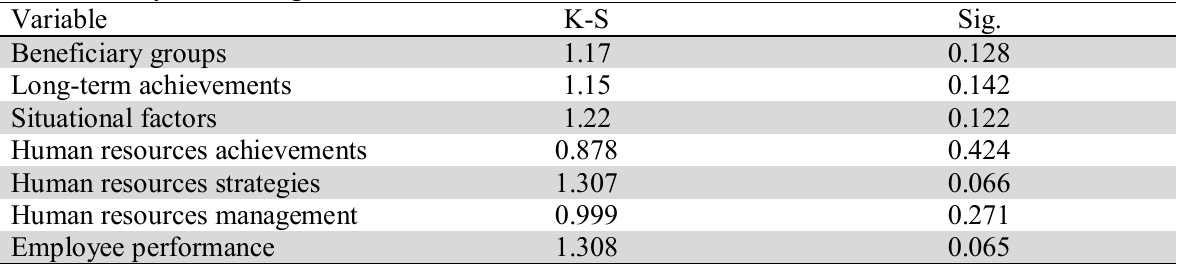
The summary of Kolmogorov-Smirnove